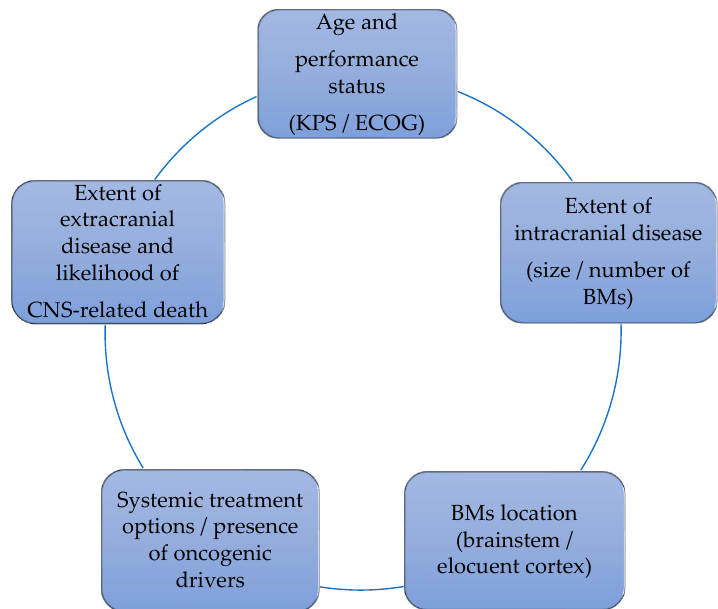
Figure 2. Factors that influence the decision on BMs management.